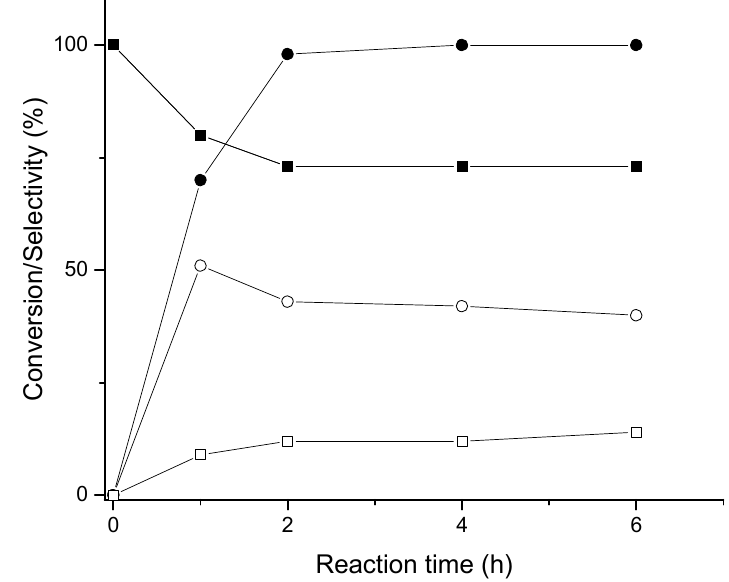
Figure 20. Conversion of m ‐ cresol as a function of time on stream at 320 °C under 1 bar over MoO 3 catalyst. Regeneration of the catalyst was performed at 400 ◦ C in oxygen for 3 h adapted from [36].